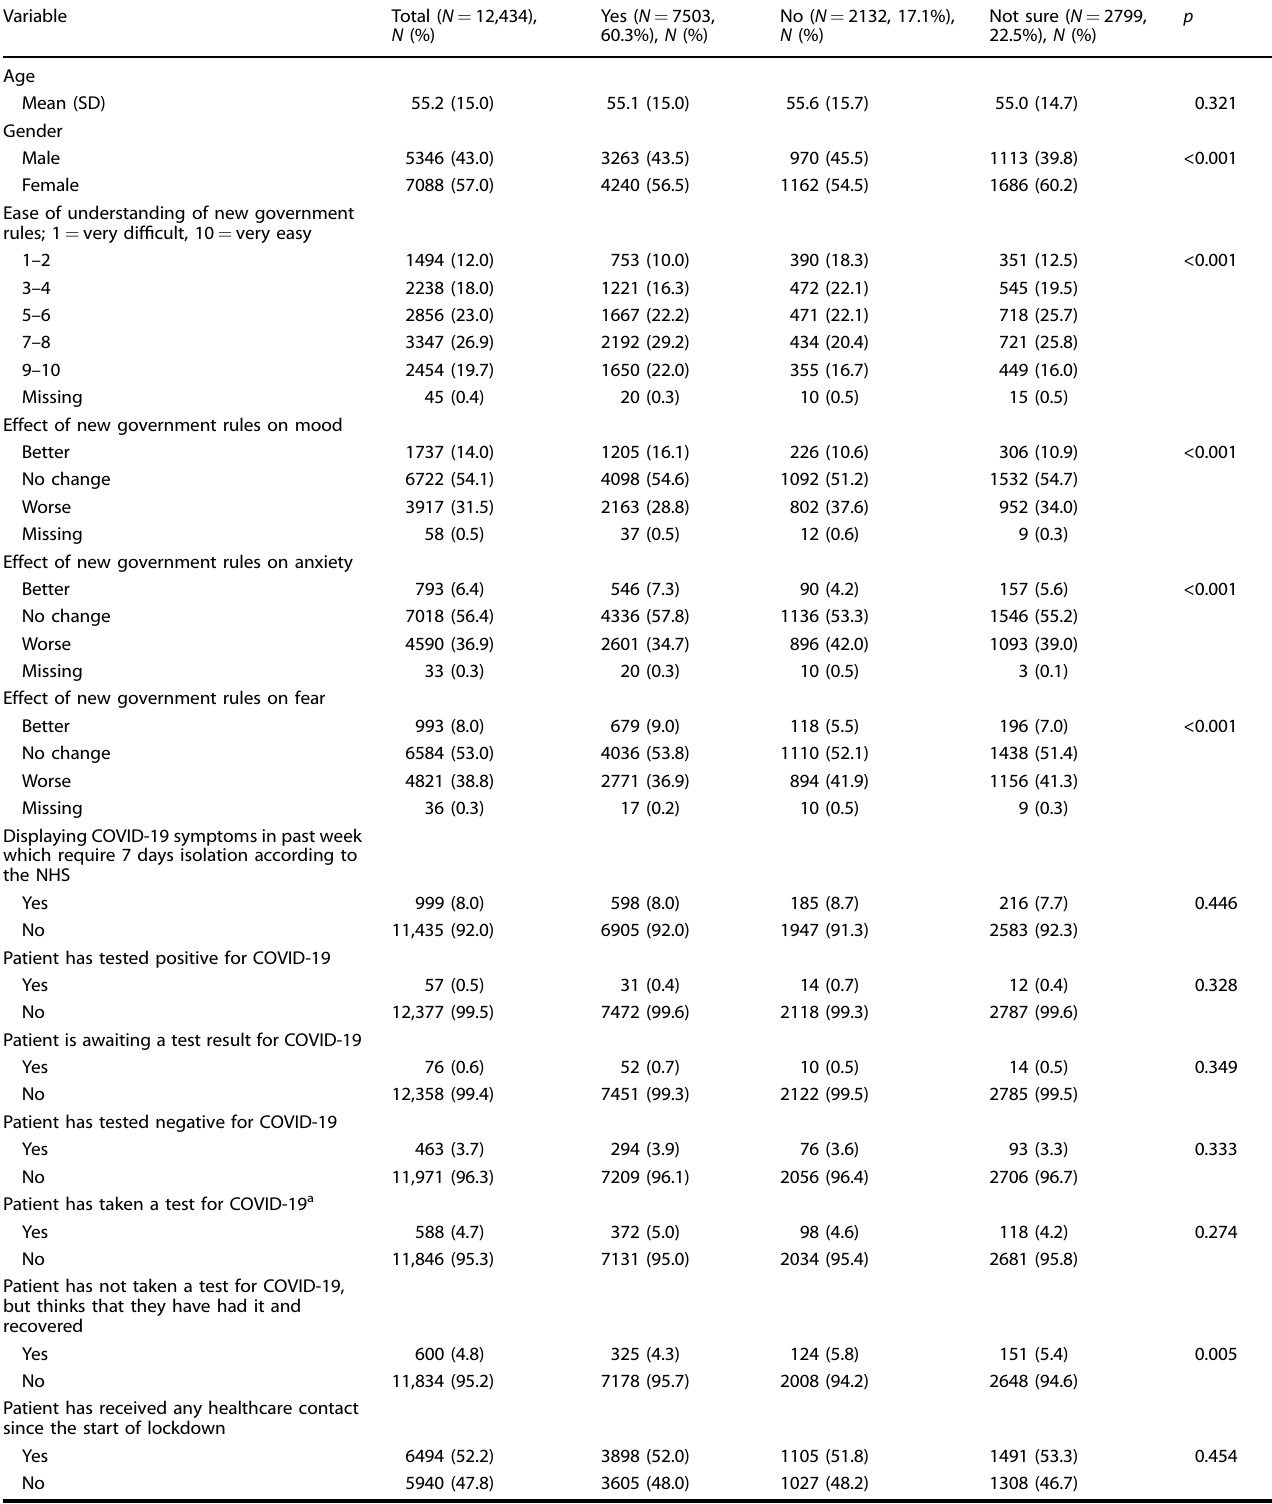
Table 1. General characteristics and questionnaire responses of the study